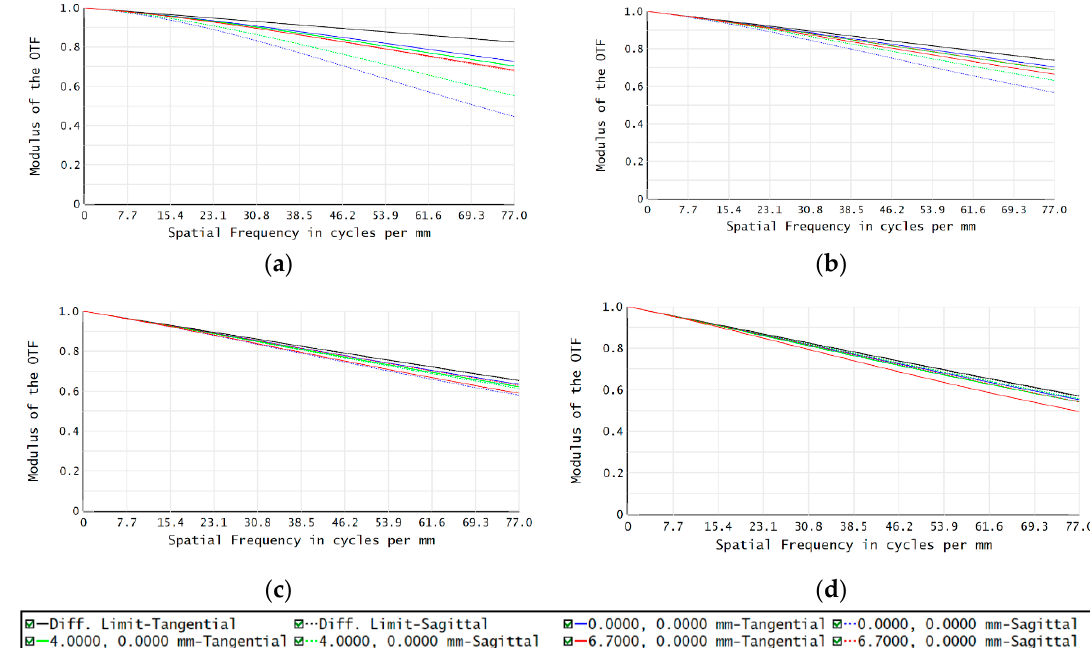
Figure 10. MTF of the Offner spectrometer ( a ) 400 nm; ( b ) 600 nm; ( c ) 800 nm; ( d ) 1000 nm.